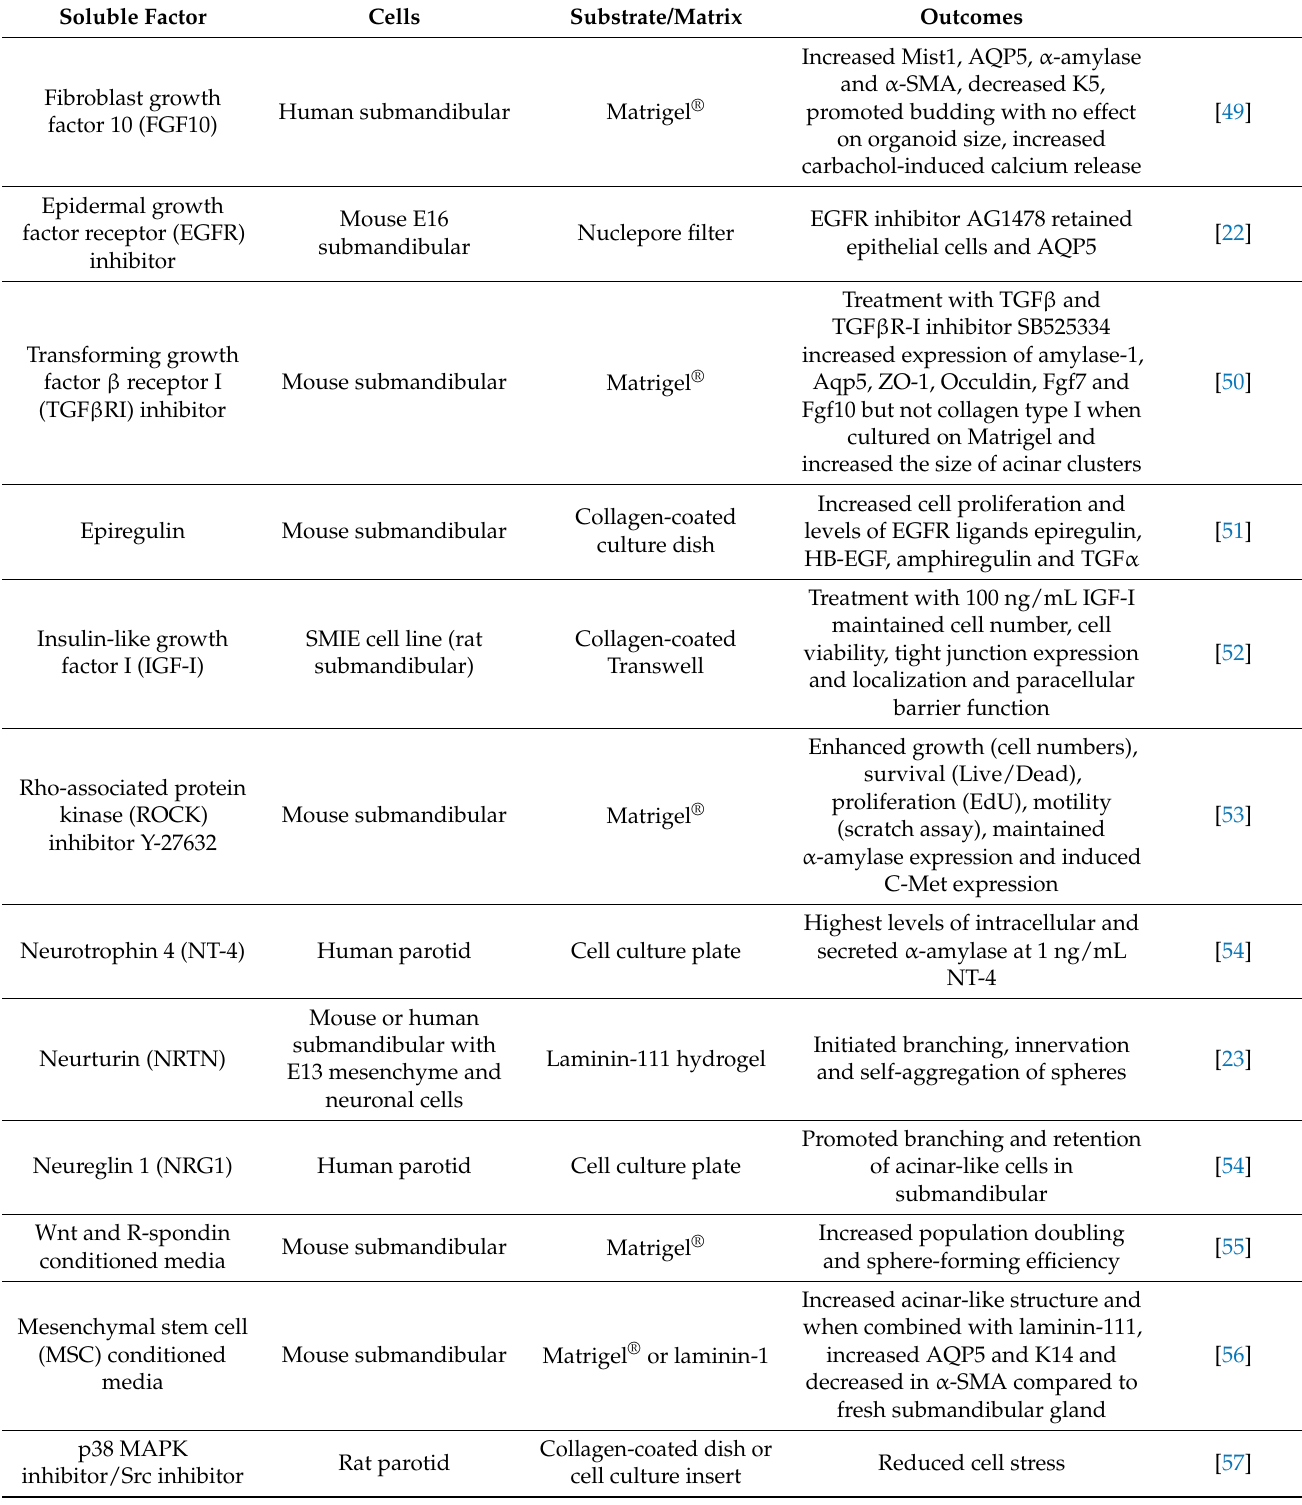
Table 2. Soluble factors and matrices for improving cultured cell